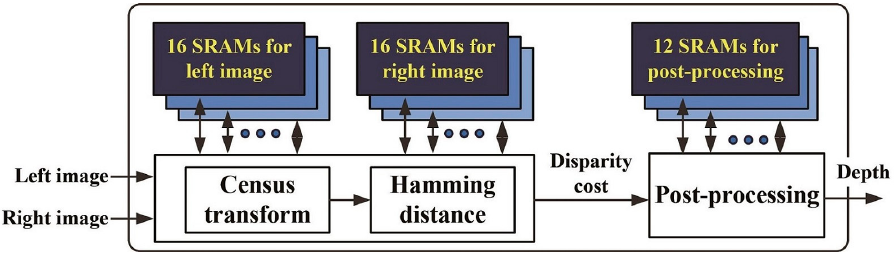
Figure 2. Flow diagram of the stereo matching processor.